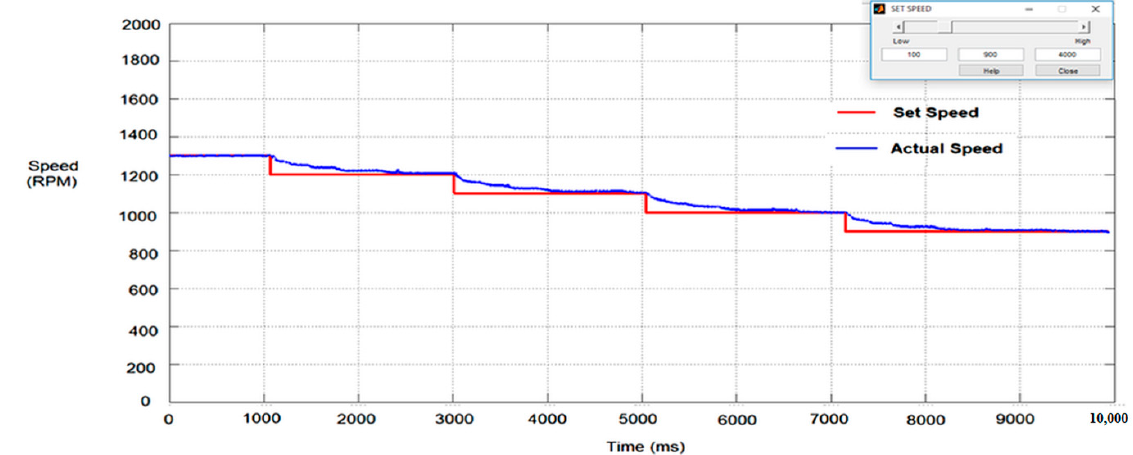
Figure 13. Actual speed of brushless DC motor tracks increased values of set speed viewed in a Graphical User Interface (GUI). Graphical User Interface (GUI).